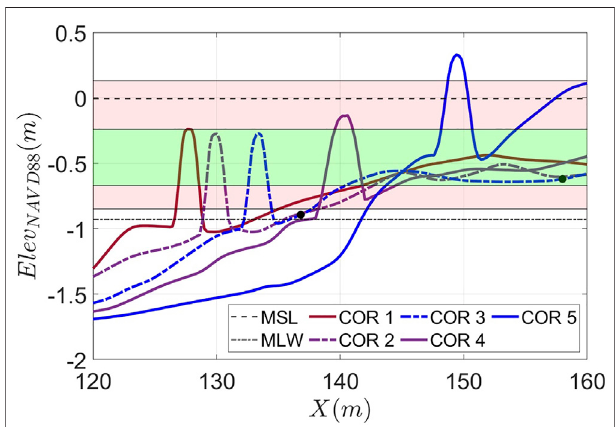
FIGURE5| Cross-sectionalviewofthe fi veCORsegments,waterlevels (MSL and MLW), OGZ (green area), and the interval between OGZ and CEB (red area). Black dots denote the locations of WG5 (left) and WG1 (right).